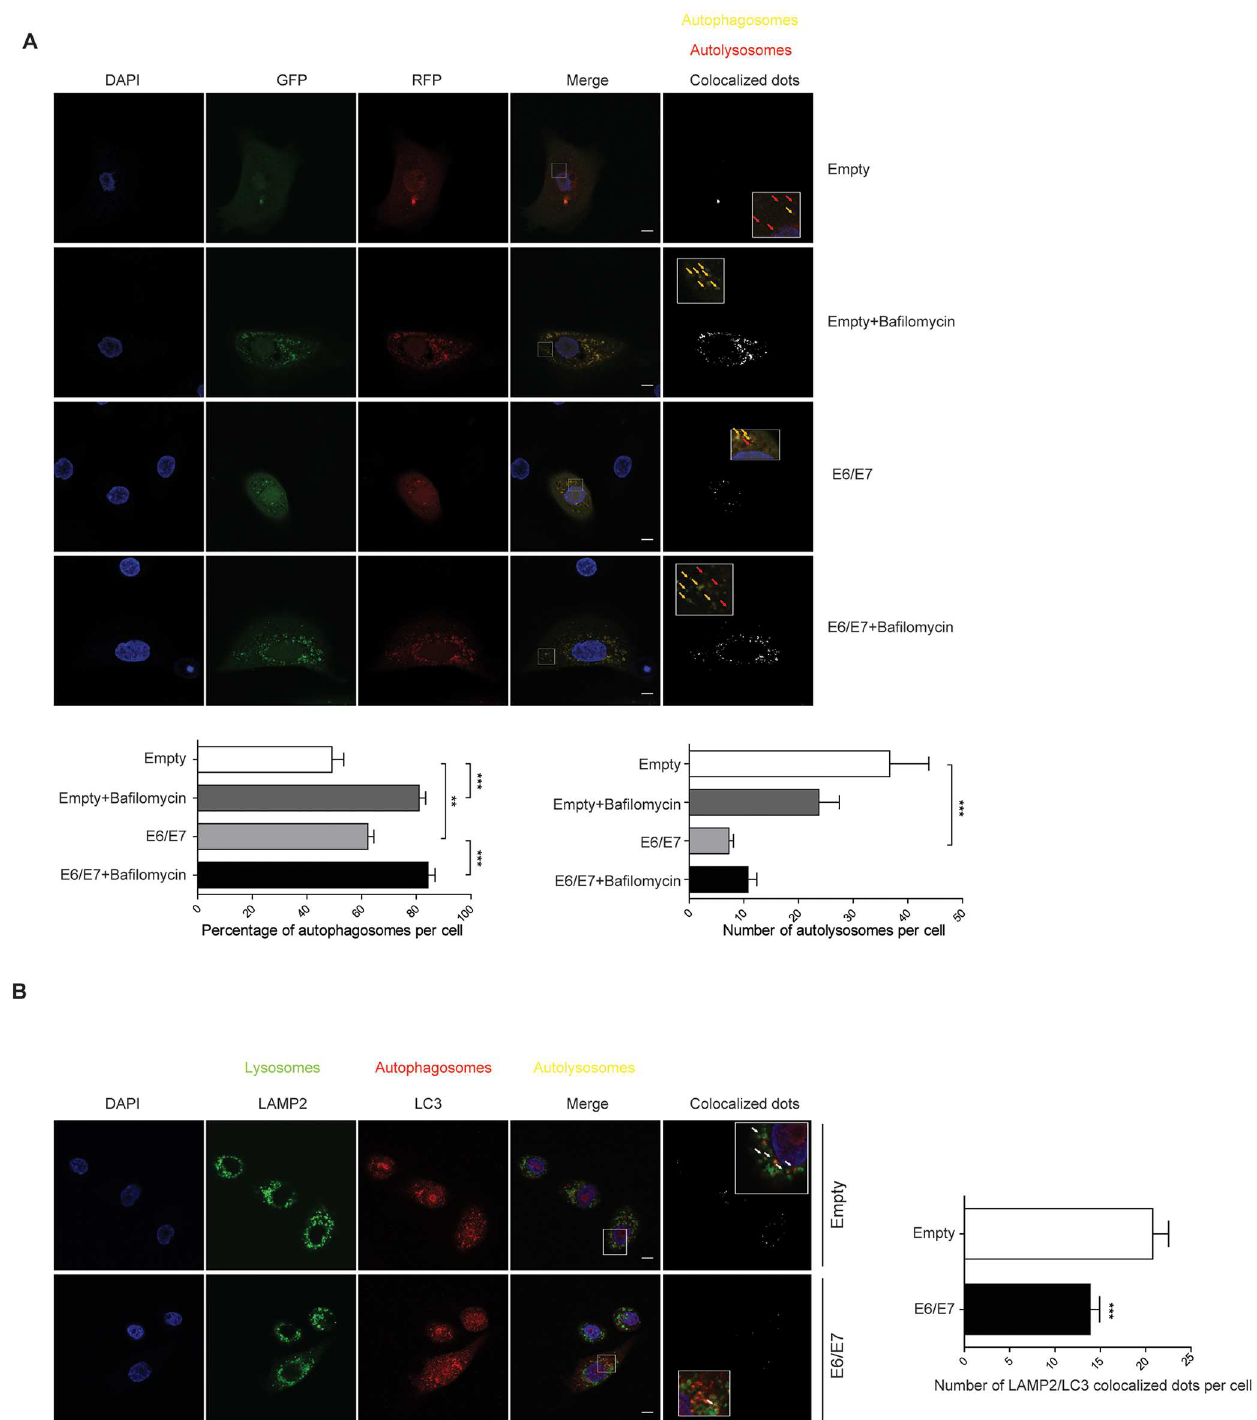
Fig 9. HPV16 E6/E7 impair autolysosomes formation. (A) Top: Confocal microscopy images of empty or HPV16 E6/E7 HKs expressingthe GFP-LC3-RFP construct and treated with bafilomycinA1 for 8 hours. Nuclei were stained with DAPI (blue). Colocalized dots images show GFP/ RFP dots colocalization as determined by the Green and Red Puncta Colocalization pluginof ImageJ. Inset show highermagnification views of boxedregions. Yellowarrows highlightcolocalizeddots (autophagosomes), red arrows indicateautolysosomes. Scale bar = 5 μ m. Bottom: quantitation of percentage of yellow puncta (autophagosomes)or red only puncta/per cell (autolysosomes). Data are expressedas percentage of yellow dots or as number of only red dots, respectively,as measured by the Green and Red Puncta Colocalization plugin.Bars represent